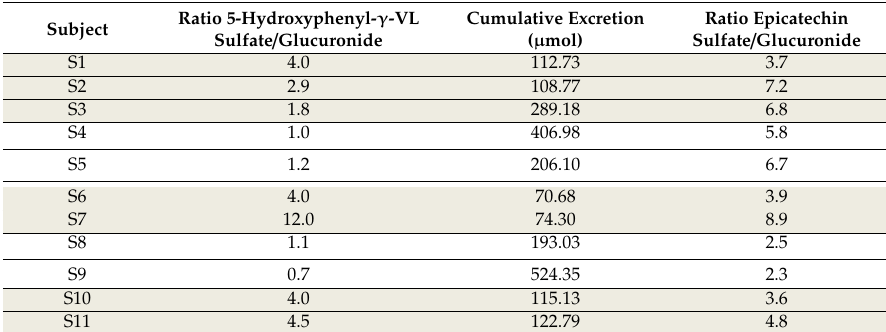
Ratio AUC (dihydroxy-PVL-sulfate / glucuronide), total AUC, and ratio epicatechin sulfate / glucuronide in the 11 study participants.